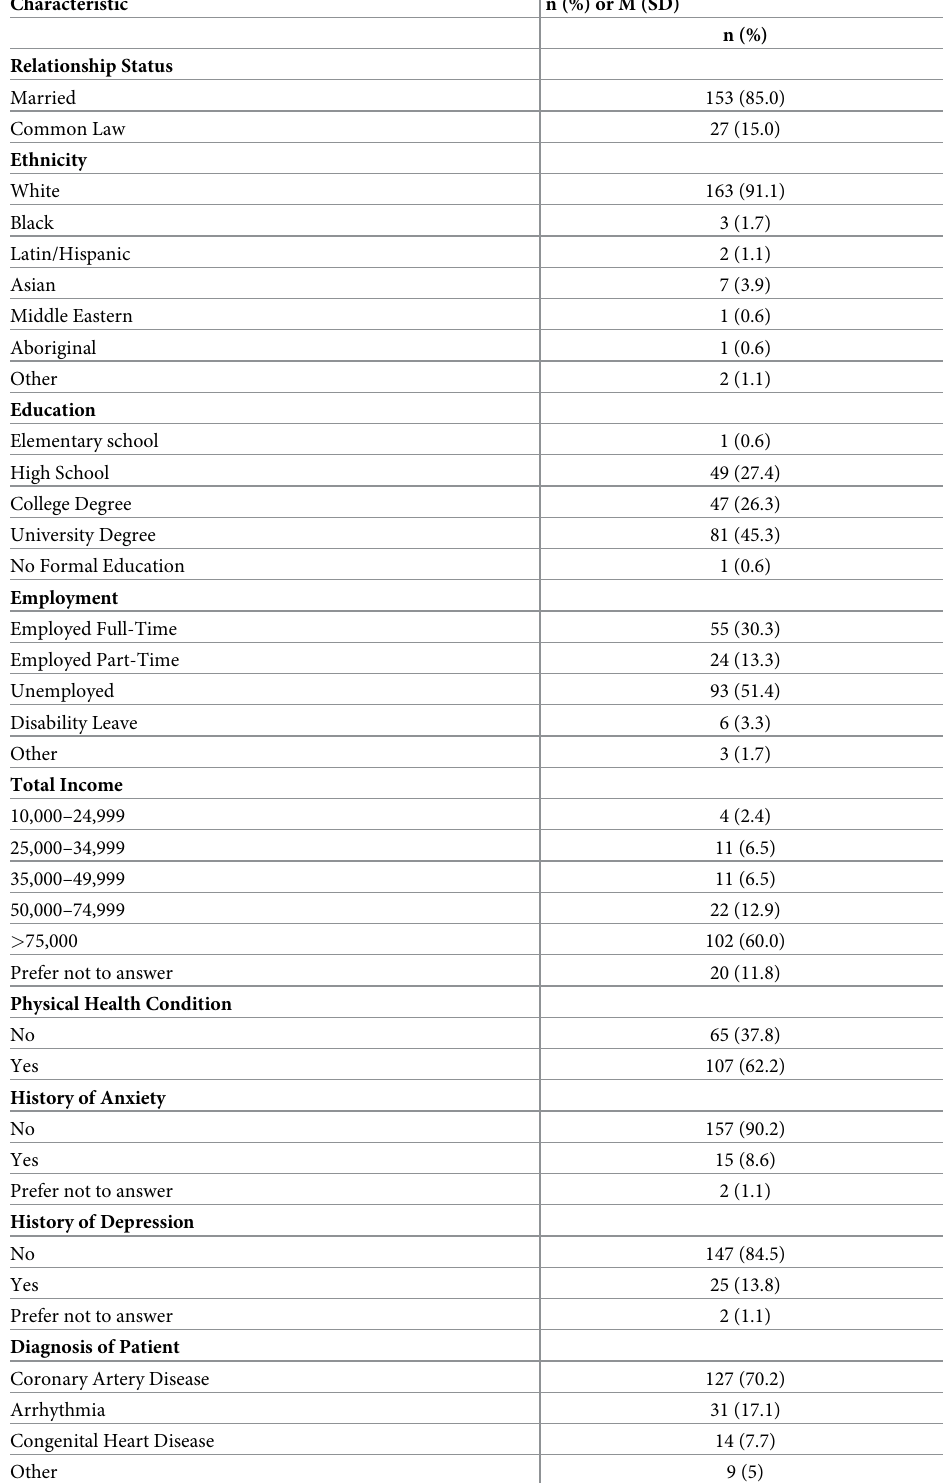
Table 1. Sample characteristics and study